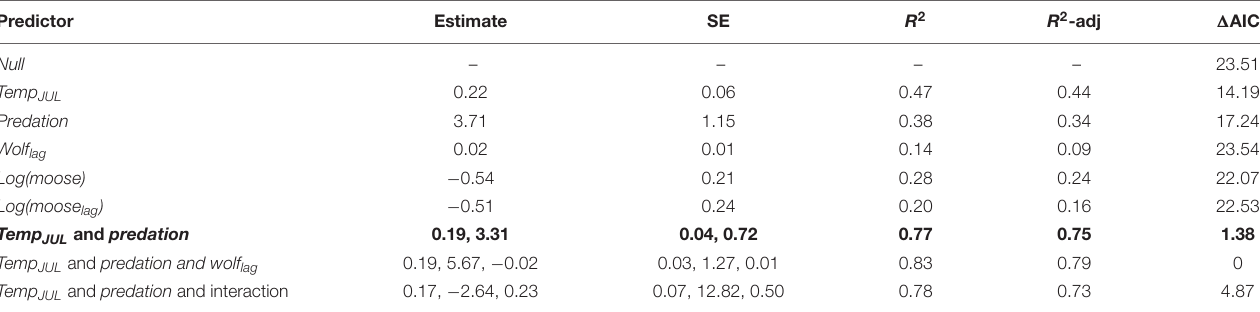
TABLE 4 | Models predicting mean annual hair loss (an indicator of winter tick burden, see Figure 1 and Supplementary Figure 1 ) for a population of moose in Isle Royale National Park over a 19-year period (2001–2019). Predictor